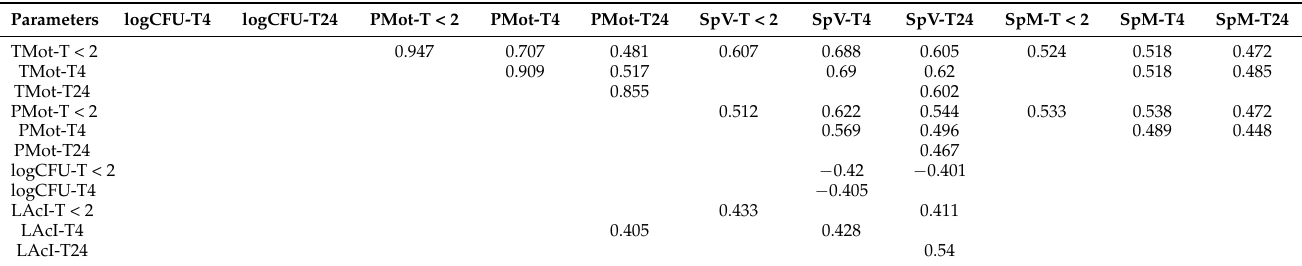
Table 2. Pearson coefficients (r) for correlations between bull semen quality parameters determined after three durations of storage in the presence of three semen extenders at two holding